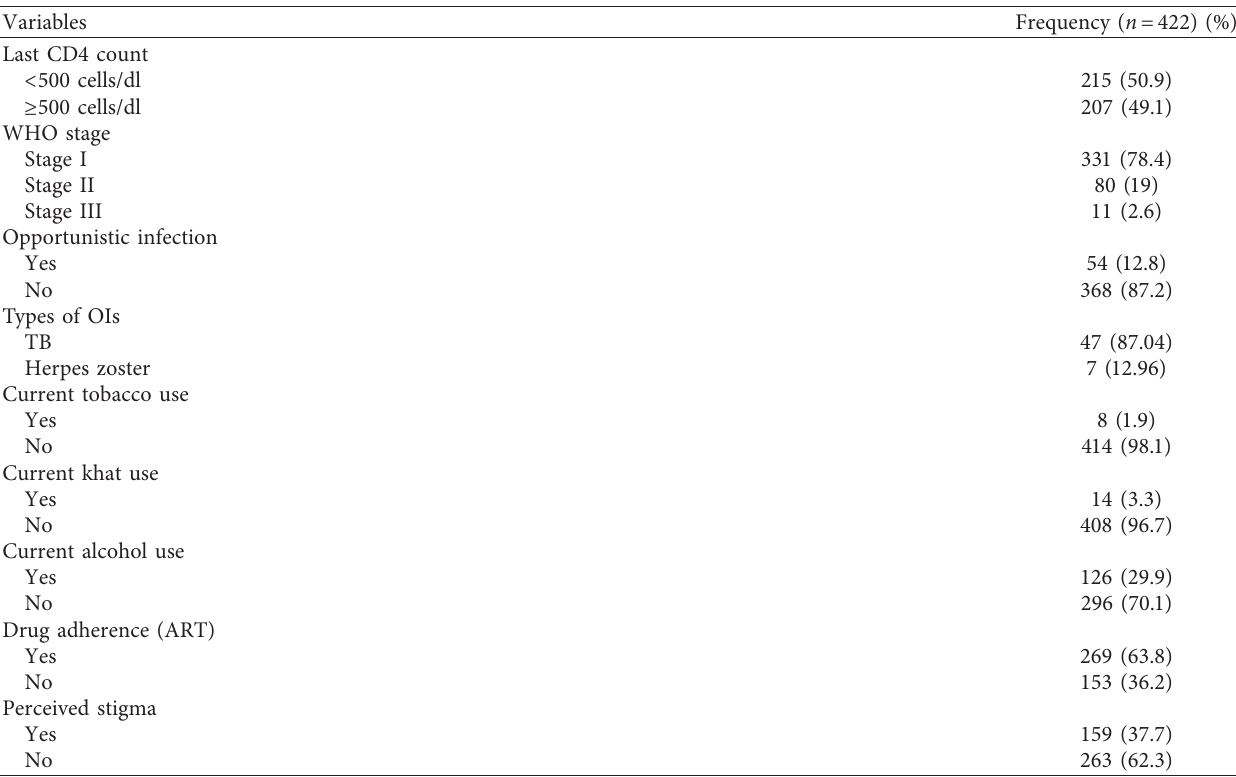
Table 2: Clinical, medication adherence, and substance use characteristics among PLHIV at selected hospitals’ ART clinics, North Shewa Zone, Amhara Regional State, Ethiopia, 2017 ( n � 422).